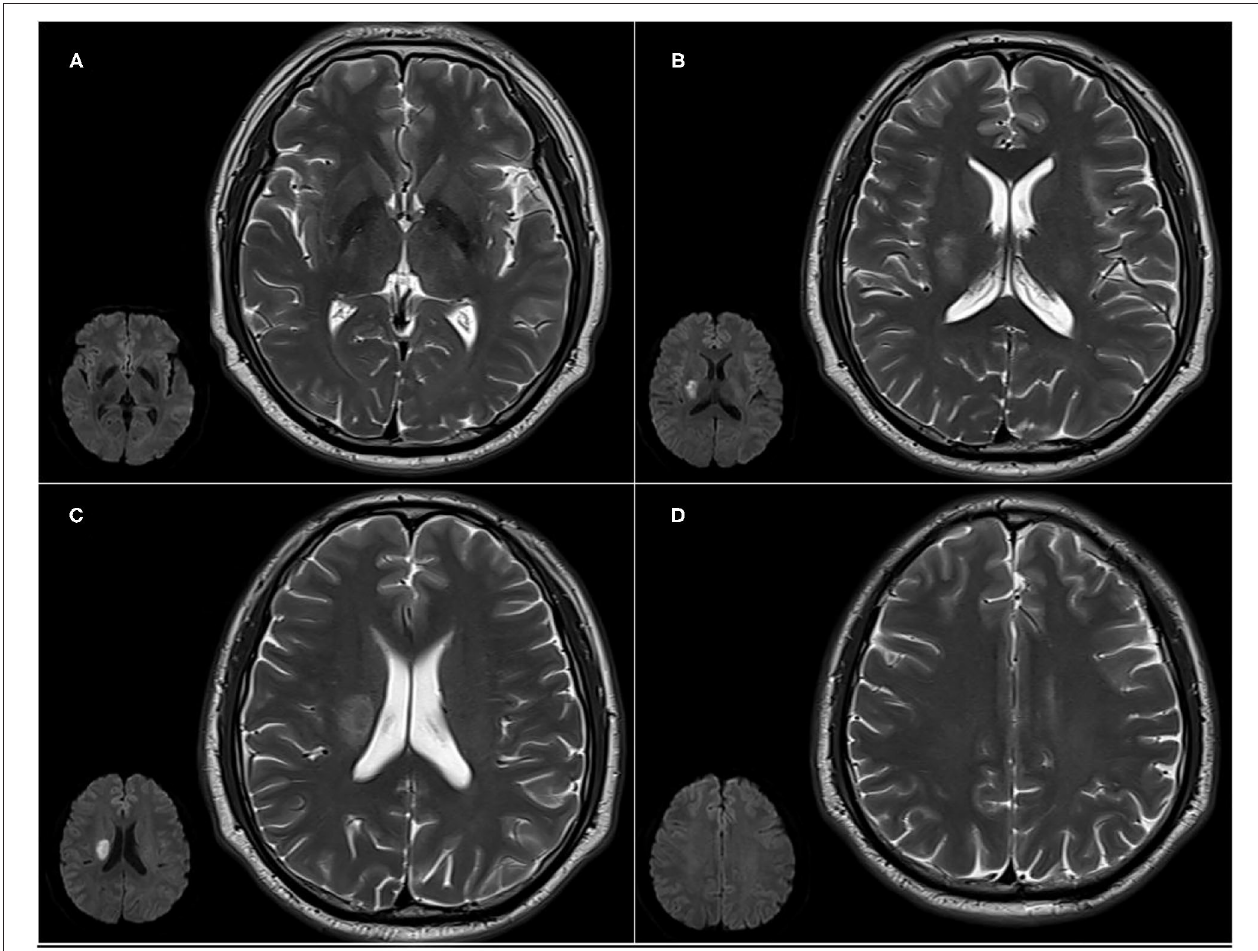
FIGURE 1 | Cholinergic Pathways Hyperintensities Scale (CHIPS) scores from representative patients with both early subacute ischemic stroke and white matter lesions (WMLs). Slices: (A) low external capsule layer (bilateral posterior zones score are 1 each, bilateral anterior zones score 0); (B) high external capsule layer (bilateral posterior zones score 1 each, bilateral anterior and cingulate gyrus zones score 0); (C) corona radiata (right posterior zone score 1, bilateral anterior and cingulate gyrus zones score 0); and (D) the semioval center (bilateral anterior and posterior zones score 0).